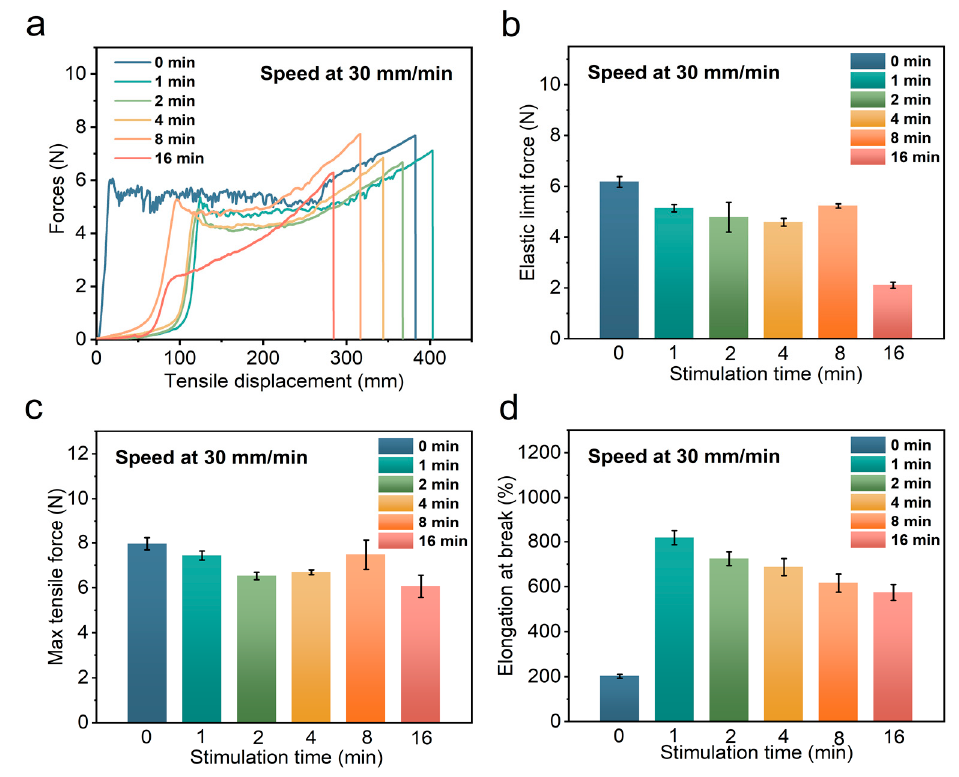
Figure 7. Force versus tensile displacement curves for bio-inspired spider material stimulated at 60 ◦ C for different times ( a ); elastic limit force ( b ); maximum tensile force ( c ); elongation at break ( d